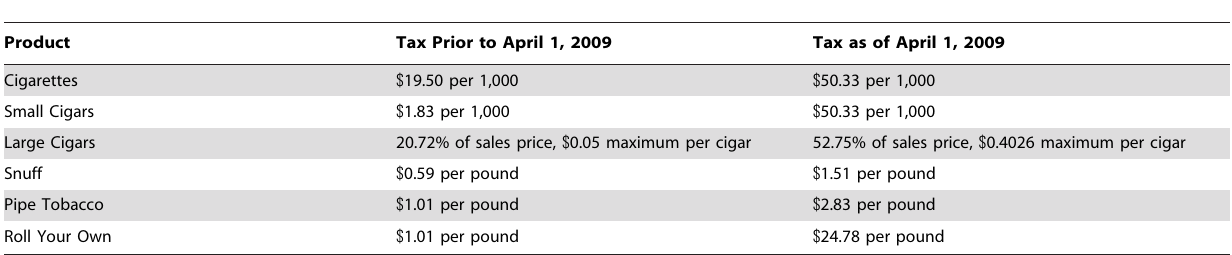
Table 1. Change in federal excise tax for all tobacco products, April 1,